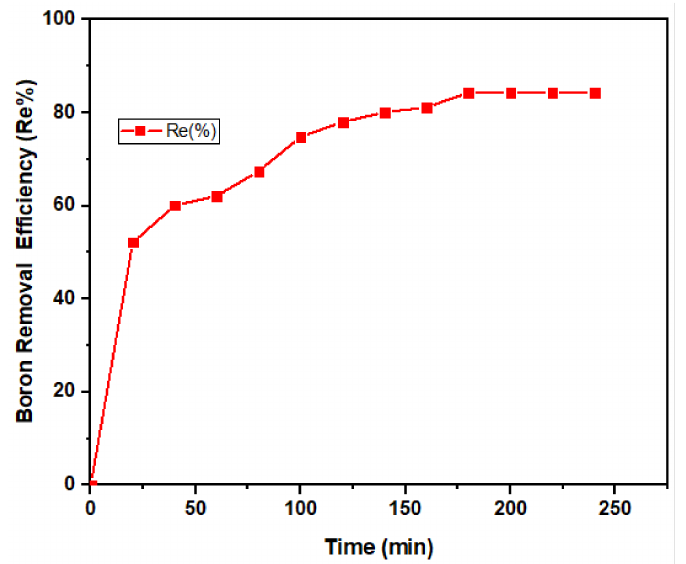
Figure 7. Boron removal efficiency by magnetite under variable contact times (20–240 min) at fixed dosage (0.5 g) and pH